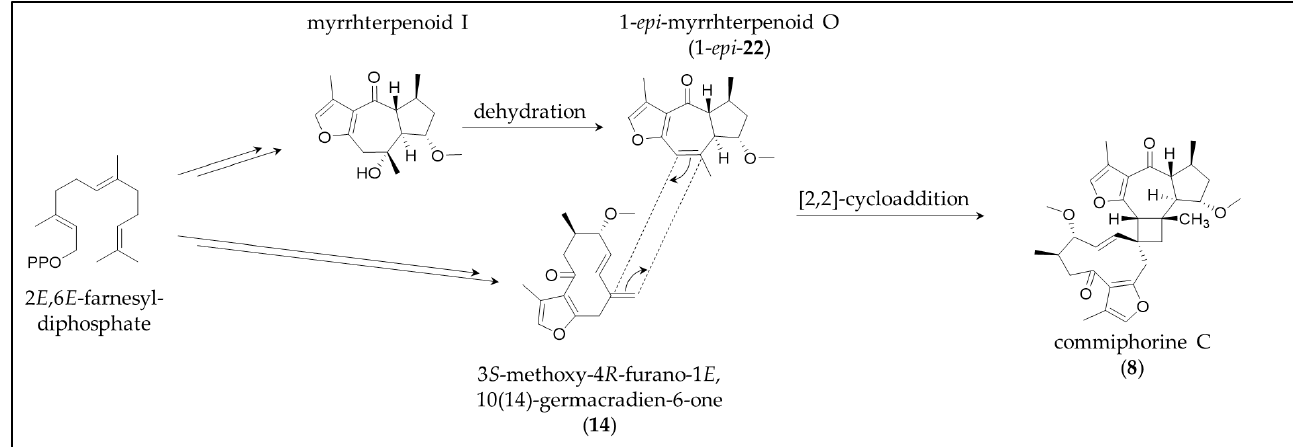
Figure 14. Plausible biosynthetic pathway for commiphorine C ( 8 ) by 2,2-cycloaddition of two monomer sesquiterpenes according to Dong et al. [21].